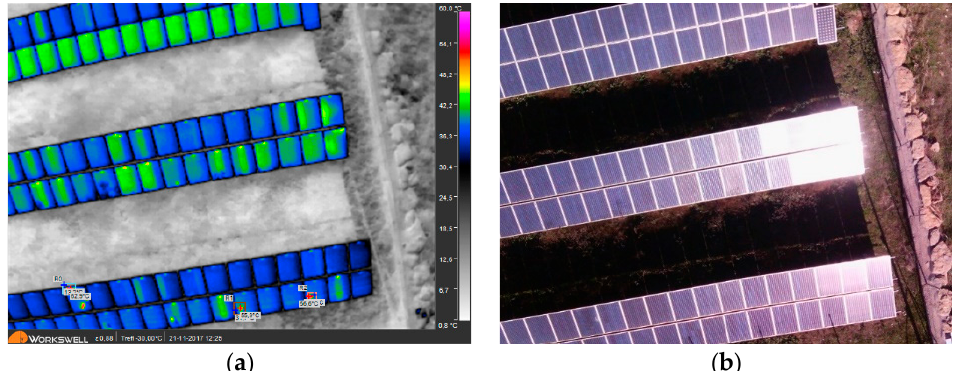
Figure 13. Thermographic analysis ( a ) and image ( b ) with an incident of PV modules with solar reflection.